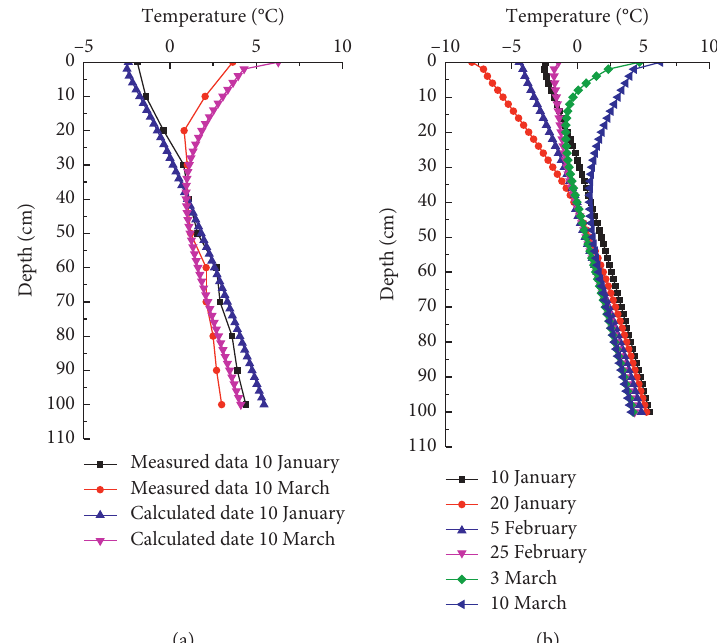
Figure 6: Numerical calculation results of temperature field.